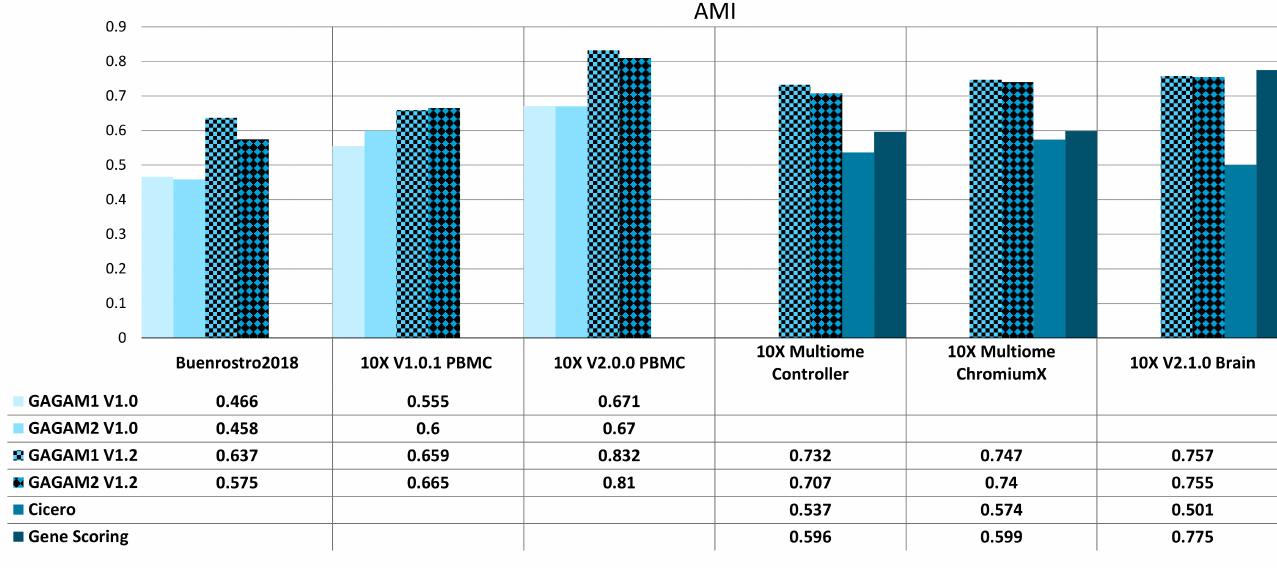
Figure 6. AMI results for both Old ( left ) and New ( right ) datasets. The Old datasets are compared with GAGAM v1.0 from [10], while the New datasets are with Cicero and